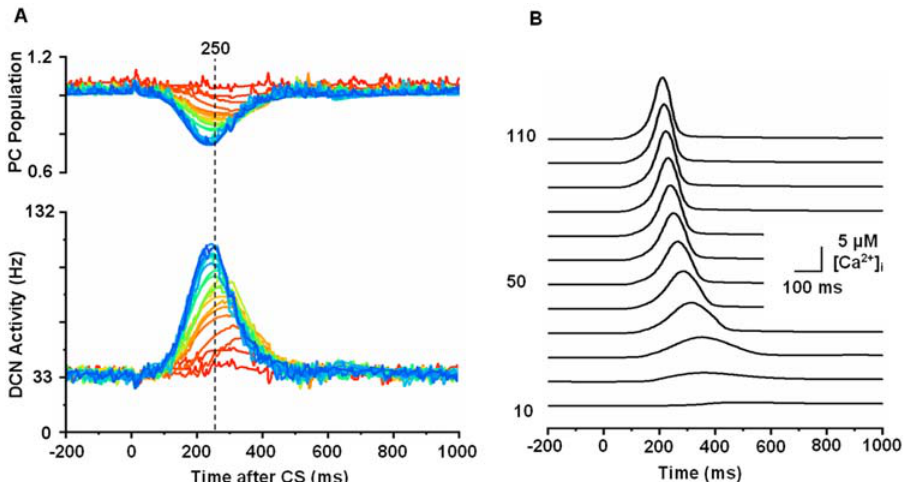
Figure 5. Simulation of learning in PC population and DCN neuron. A. Upper panel: Traces of postsynaptic weighted sum in DCN of outputs from the PC population. Lower panel: Traces of DCN neuron activity with a baseline firing rate of about 33 Hz. Twenty test trial responses (every 15th trial during learning) are shown, starting at the beginning of training (red) and progressing to the learned state after 300 trials (blue). The ordinate of the upper panel has an arbitrary scale. The number (250) above the broken line indicates the ISI time in ms. Subsequent figures use these same conventions. B. Increment of excitability and early onset of the peak of PF-induced [Ca 2 + ] i profile. The curves show PF-induced [Ca 2 + ] i profiles in the model PC spine at PF-alone test trials after different numbers of PF-CF conjunctive trials (indicated on the left side of the figure, 10 , 110 times). Every 10 th trial is shown for clarity. The curves show that as the PF-CF conjunction progresses, the model spine responds with an increased volume of [Ca 2 + ] i at earlier times due to the facilitated kinetics of calcium activation. The time shift of the peak saturates as the learning progresses. See text for more details.